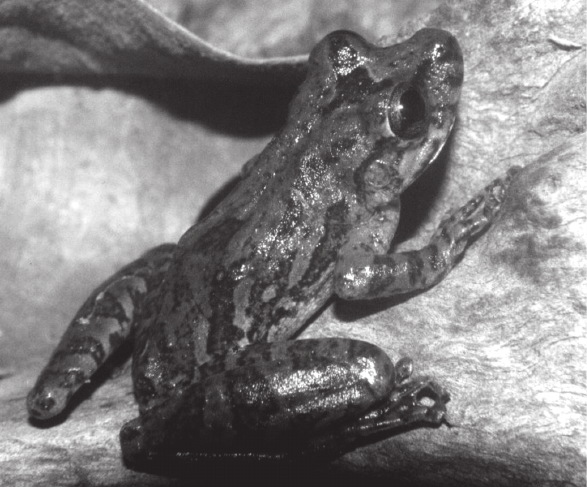
Figure 7. Adult female in life of S. skaios sp. nov. (MCNAM 6220) from the type-locality at municipality of Santa Rita do Novo Destino, state of Goiás, Brazil. Photo by